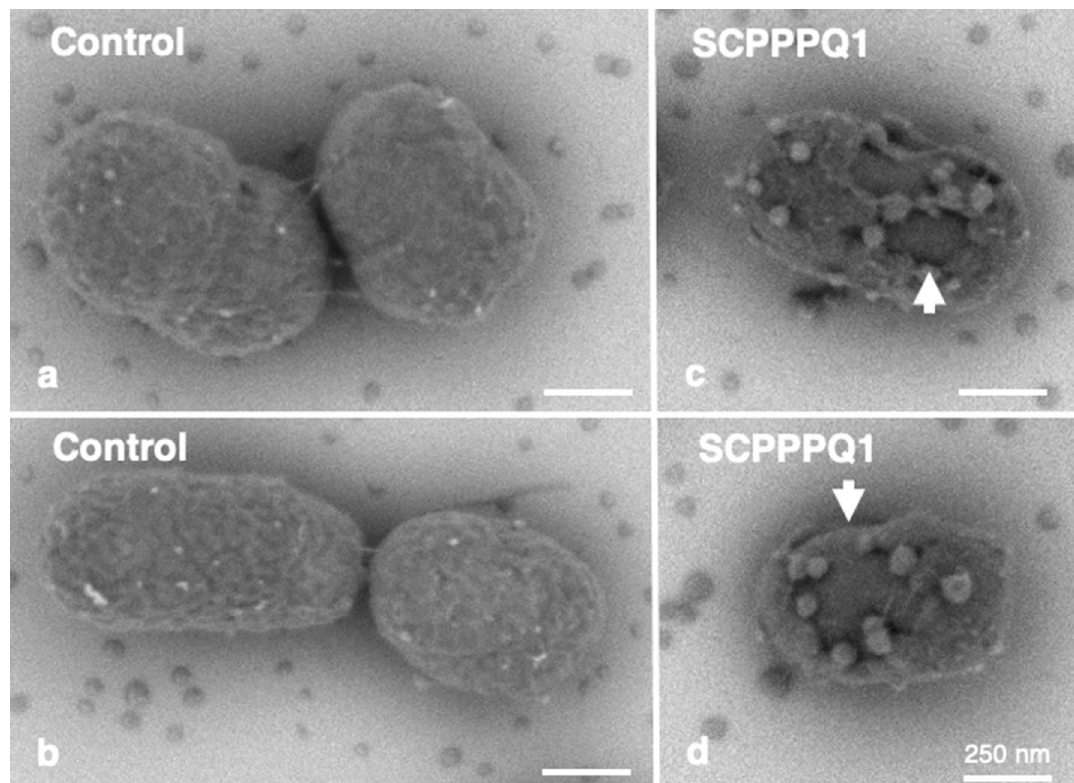
Figure 4. Scanning electron microscopy (SEM) imaging of the bacterial surface. Cultures of P. gingivalis were incubated in ( a , b ) the absence (buffer only, control) or ( c , d ) presence of SCPPPQ1 (20 µM) for 2 h. Bacteria were then deposited on titanium disks, allowed to adhere for 30 min and processed for high-resolution SEM imaging. P. gingivalis, incubated with buffer only ( a , b ) show intact membranes, while incubation with SCPPPQ1 ( c , d ) results in important surface breaches (arrows) and abundant